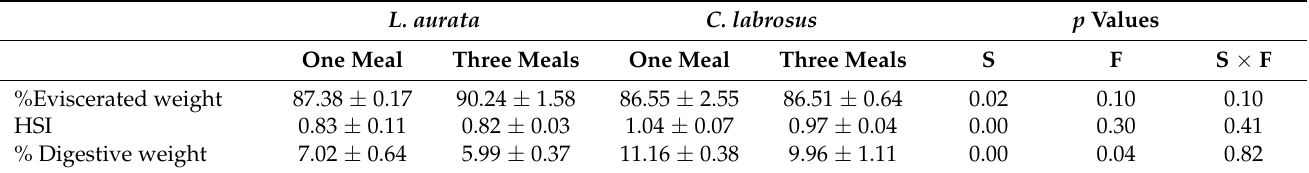
Table 3. Somatic indexes expressed by species (S) and feeding frequency (F) (n = 18). L.